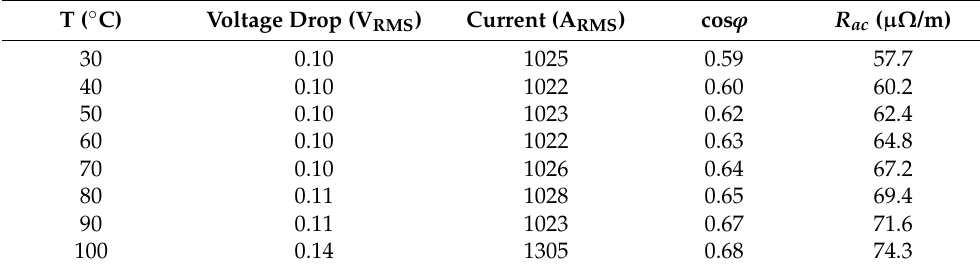
Table 4. Dependence of R ac with the temperature of the